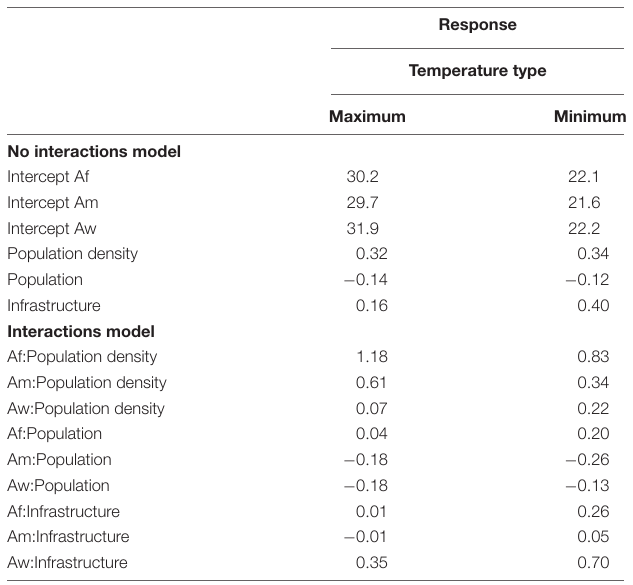
Standardized coefficients from two multivariate regression models for factors affecting temperature in tropical